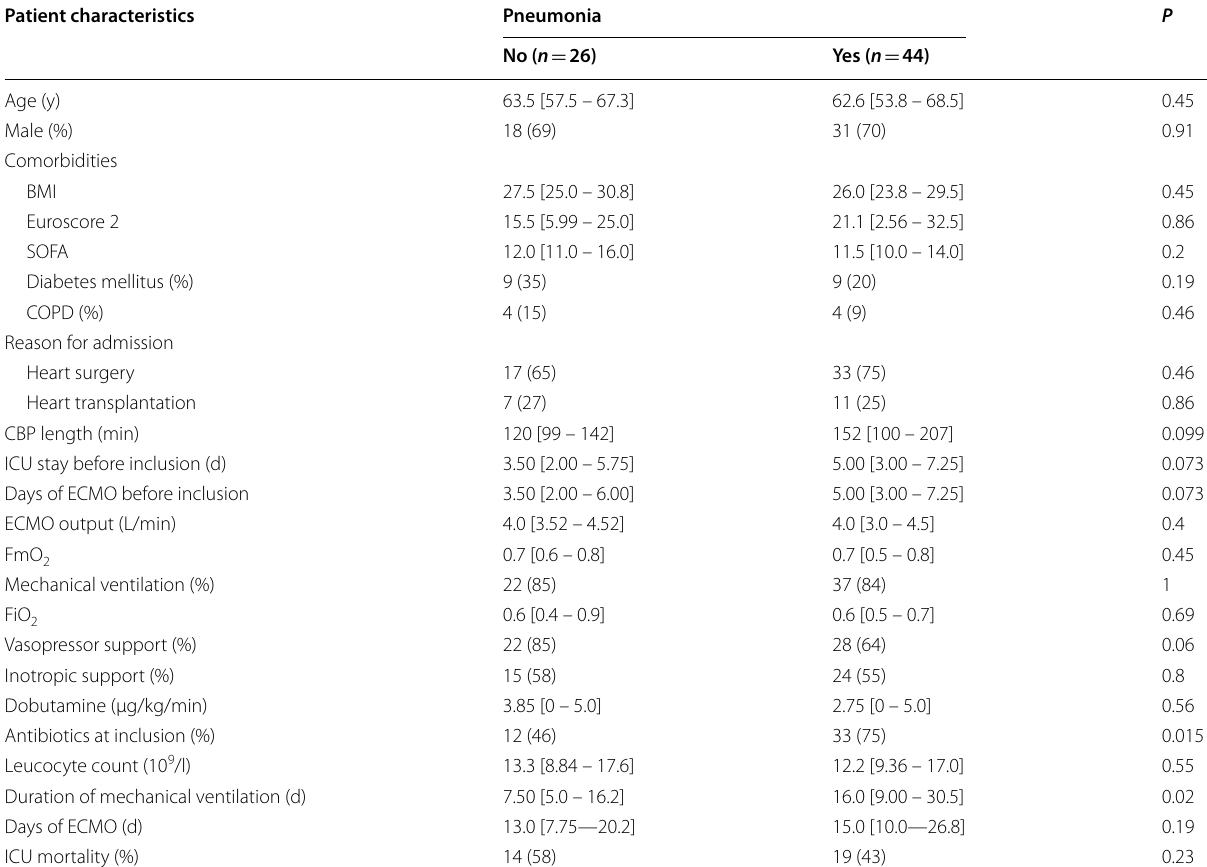
Table 1 Patient characteristics grouped by the presence or absence of pneumonia